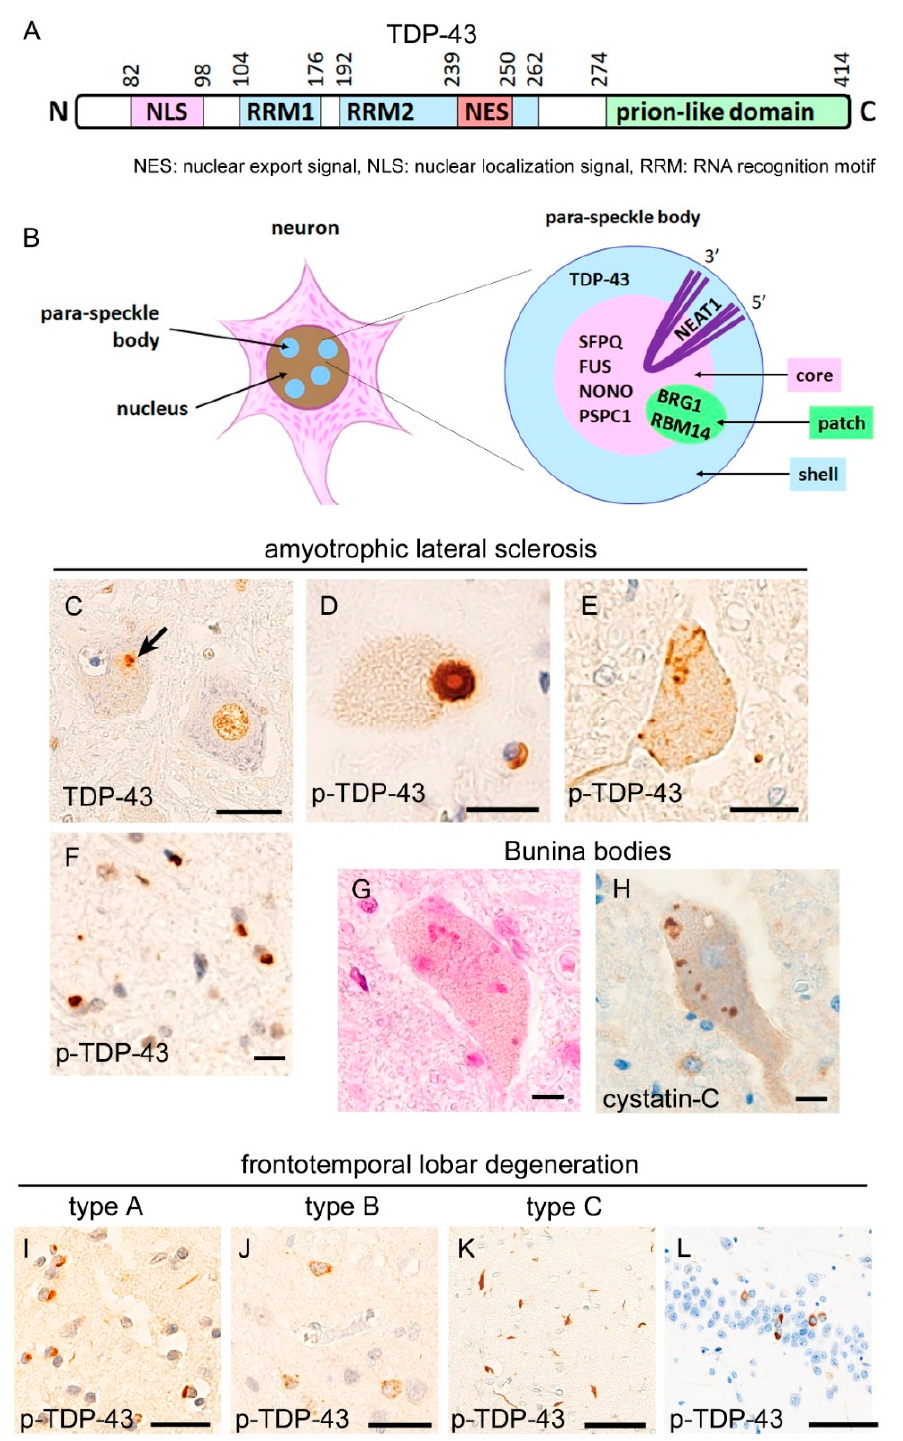
Figure 1. Neuropathological findings of TDP-43-proteinopathies. ( A ) TDP-43 contains nuclear localization (NLS) and export (NES) signals and RNA recognition motifs (RRMs). The C-terminal side has a glycine-rich domain (prion-like domain) [9,12]. ( B ) Intranuclear para-speckle body is an important scaffold of RNA-binding proteins, including TDP-43, SFPQ, and FUS, interacting with V-shaped lncRNA, NEAT1. The shell comprises the TDP-43 and 3 ′ /5 ′ -ends of NEAT1, whereas the core comprises SFPQ, FUS, NONO, and PSPC1 [14]. Panels ( C – H ) display pathological findings of spinal cord motor neurons from amyotrophic lateral sclerosis patients. TDP-43 pathology comprises mislocalization from nucleus and cytoplasmic aggregates ( C , arrow). TDP-43 aggregates often appear as round ( D ) or skein-like ( E ) inclusions. Oligodendrocytic inclusions are also observed ( F ). Bunina